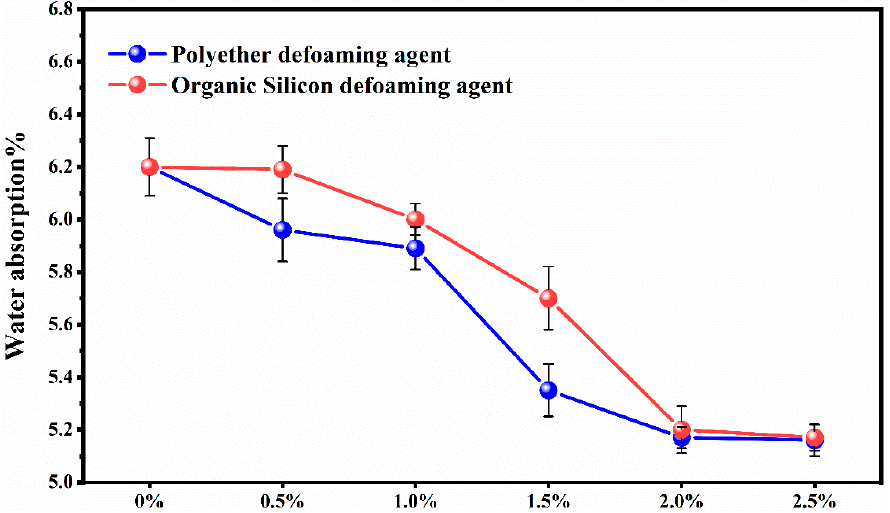
Figure 10. Water absorption.